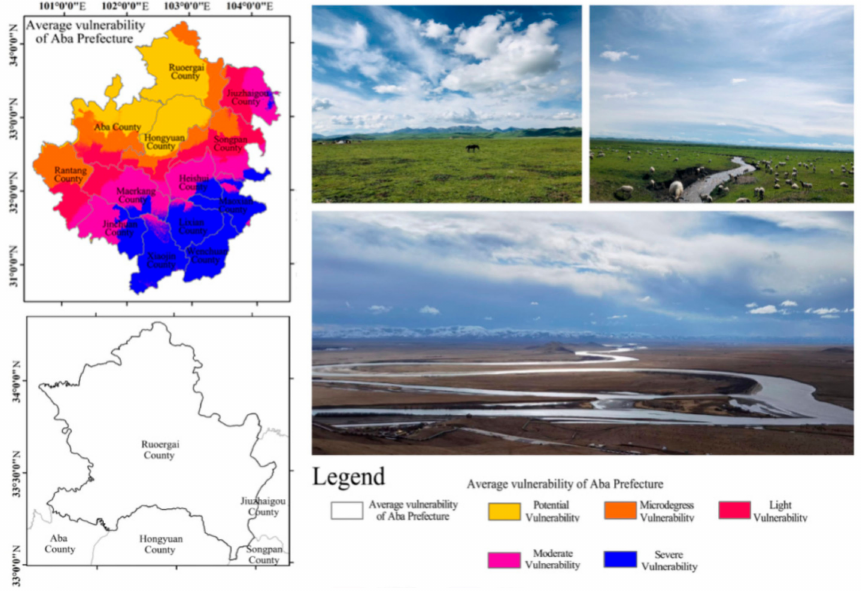
Figure 10. Spatial distribution of socio-ecological vulnerability in Ruoergai County,